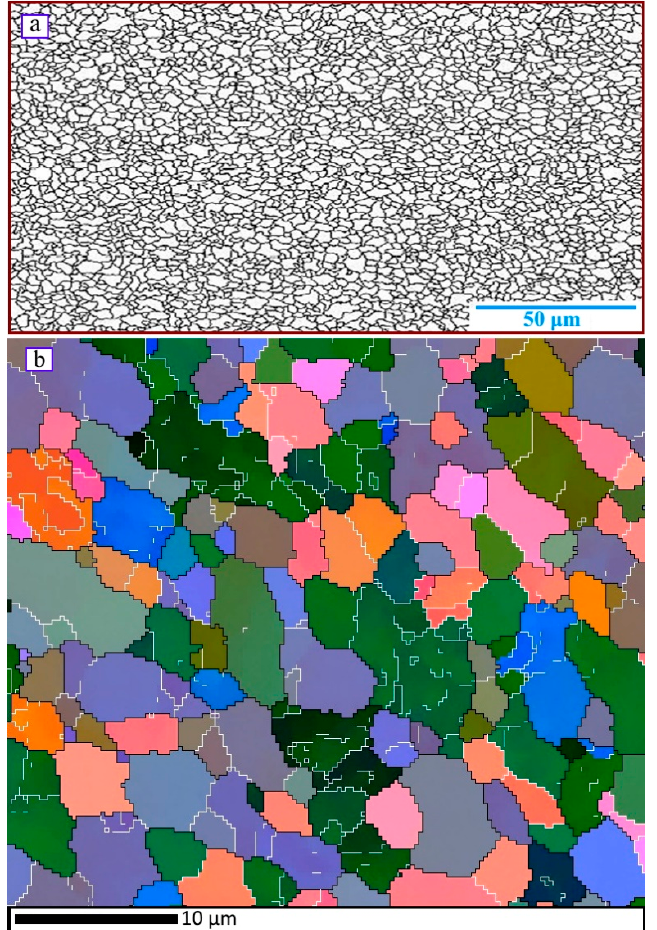
Figure 8. ( a ) Optical micrograph of grain boundaries image of FSP specimen, ( b ) EBSD orientation map (white colour for LAGBs and black colour for HAGBs).